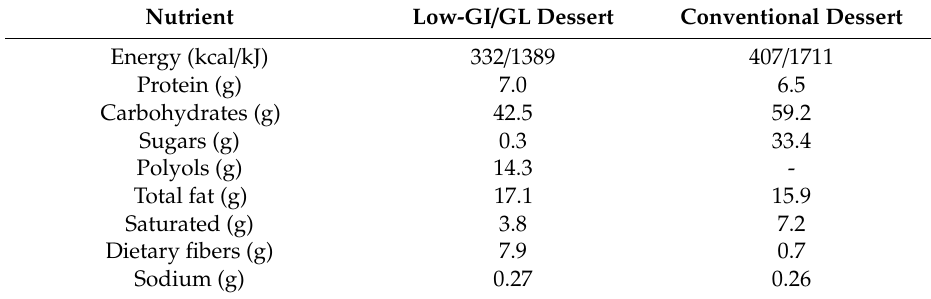
Table 2. Nutritional value per 100 g of the two desserts (conventional and low glycemic index / load) consumed by patients with type 2